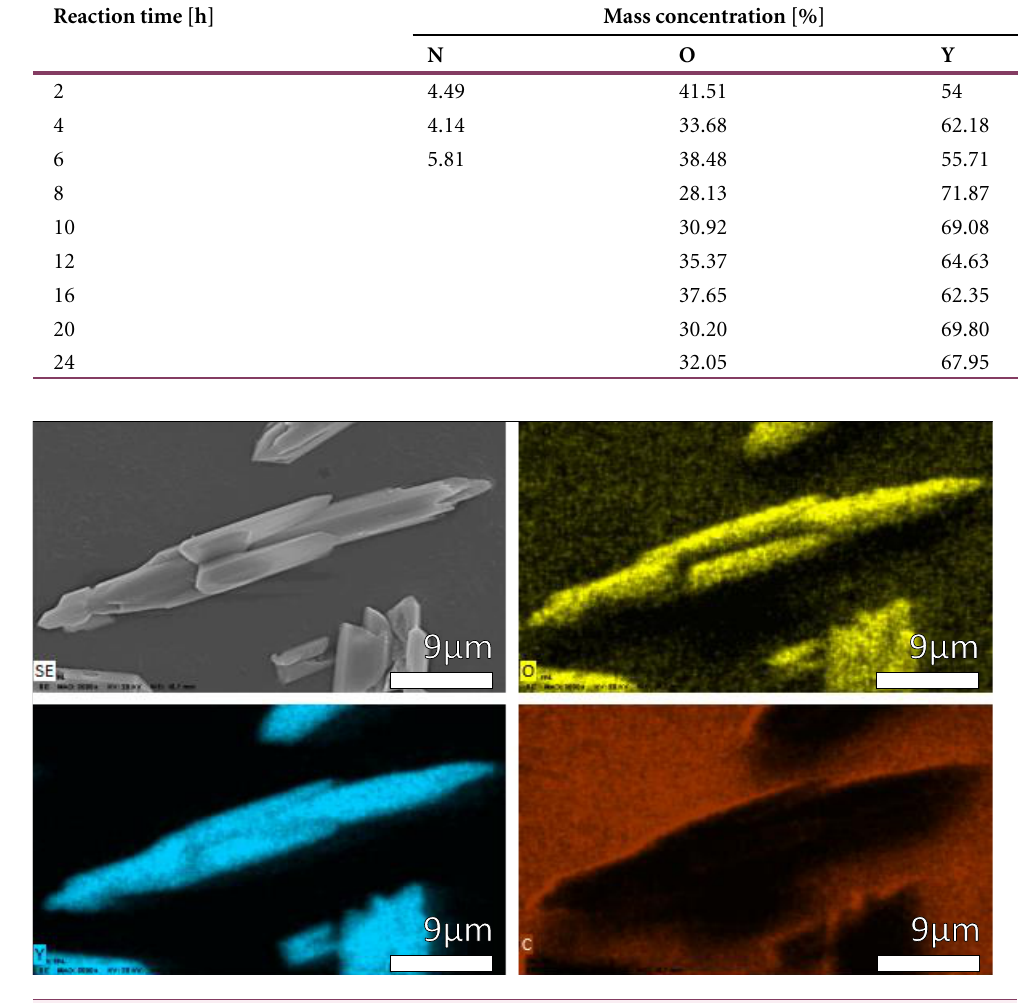
Figure 8 EDS mapping of Y(OH) 3 obtained at 12 h.